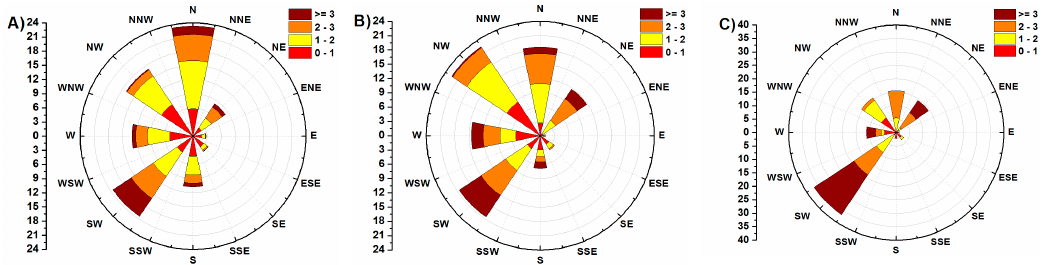
Figure 7. The wind rose for O-P: ( A ) years 2012–2018; ( B ) year 2018 and ( C ) December 2017–February 2018.